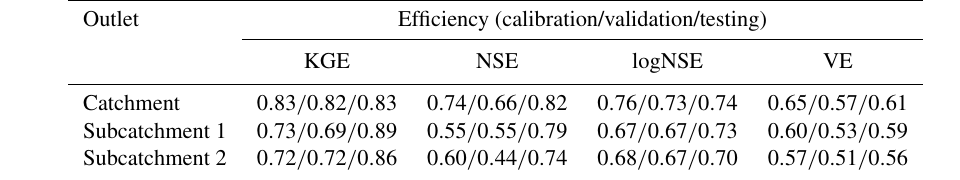
Table 5. Performance matrix of MIKA-SHA_SUPERFLEX.